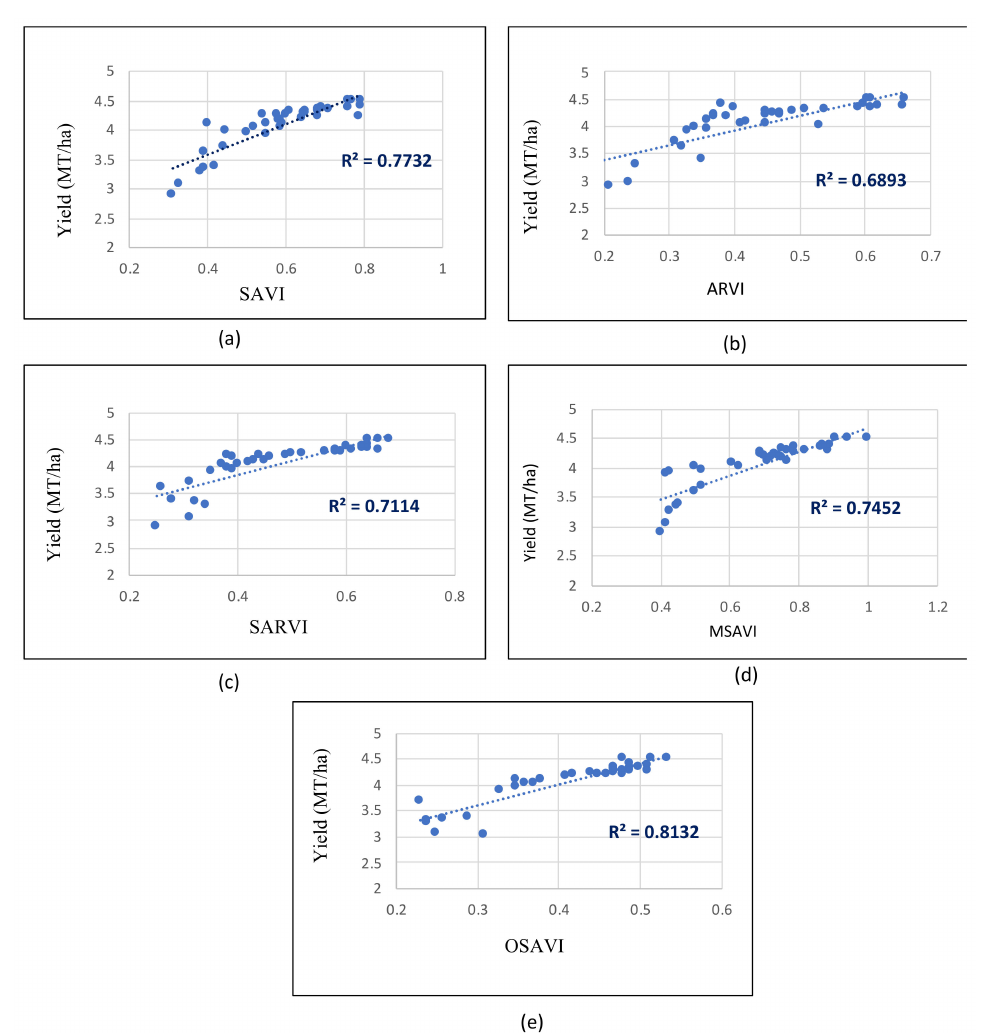
Figure 9. Regression analysis for vegetation indices and ground reference time series yield information. ( a ) SAVI, ( b ) ARVI, ( c ) SARVI, ( d ) OSAVI, ( e )